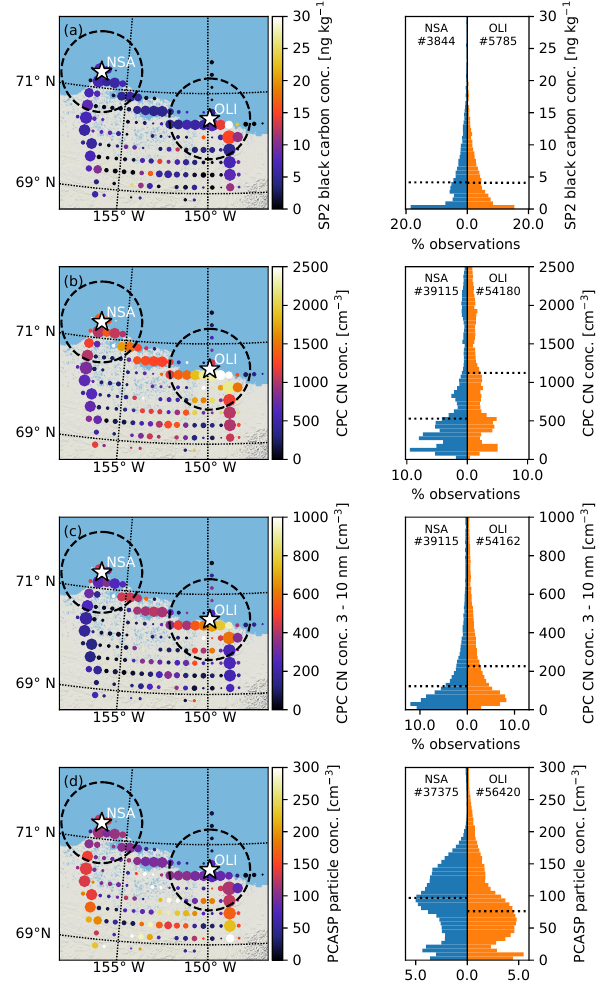
Figure 3. Left column: spatial distribution of mean (a) SP2 refrac- tory black carbon concentration, (b) CPC3025 CN concentrations, (c) difference between CPC3025 and CPC3010 CN concentration corresponding to a size range of 3 to 10nm, and (d) PCASP aerosol concentration. Only non-cloudy observations below 500ma.m.s.l. have been considered. The size of the dots is proportional to the number of observations. The dashed circles correspond to a dis- tance of 90km. Right column: here, the distribution of measure- ments within the 90km circles are shown; the number above the distribution shows the number of observations. The horizontal dot- ted bar denotes the median